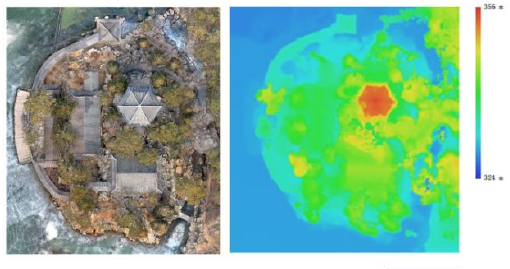
Figure7 .Positive image and DEM data of Jinshan tilt photography model (From Xie Lindong)